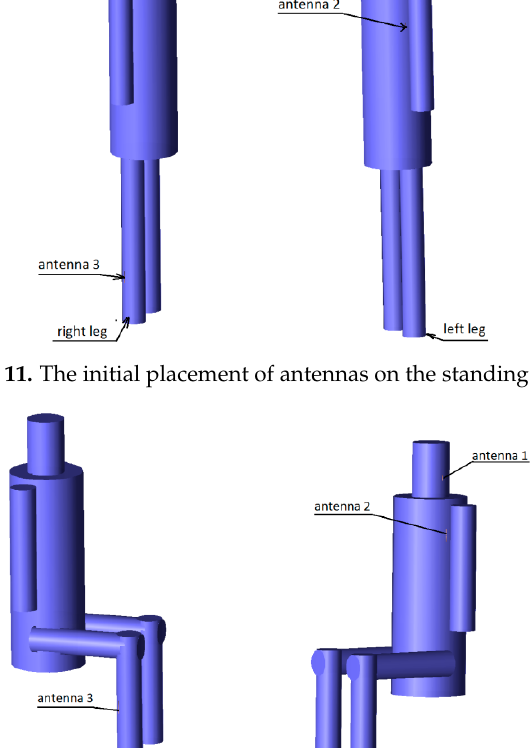
Figure 12. The initial placement of the antennas on the sitting model.